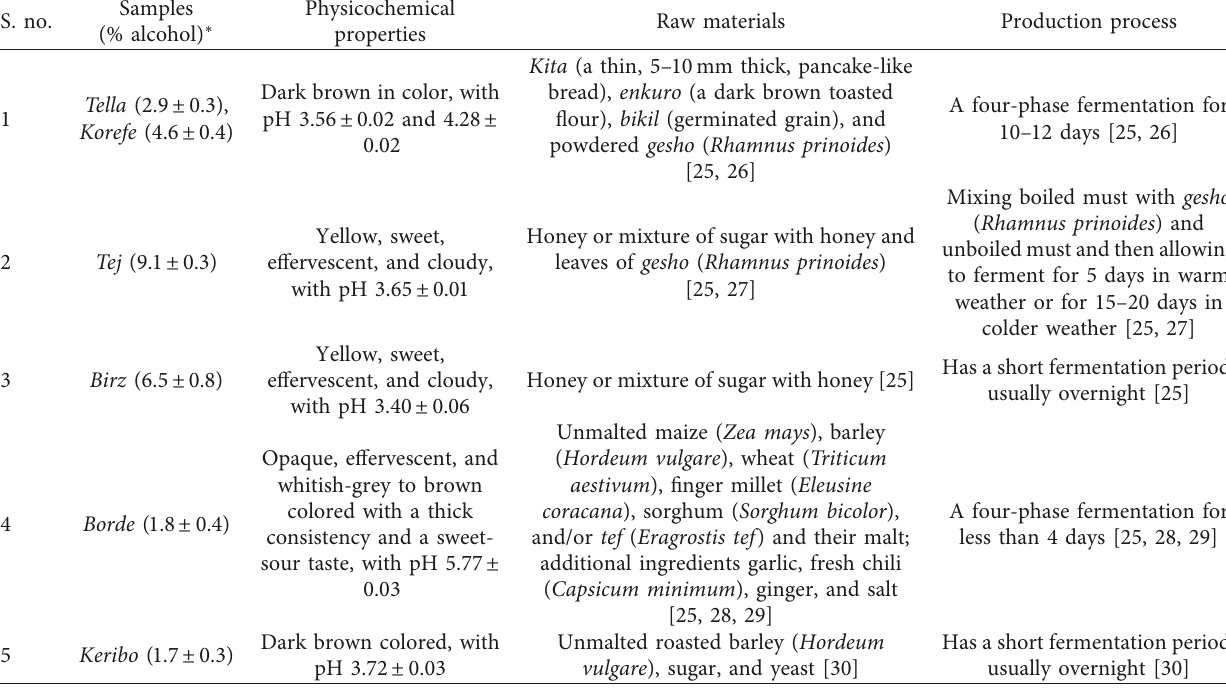
Table 1: Physicochemical properties, raw materials, and production process of some Ethiopian traditional alcoholic beverages. S.